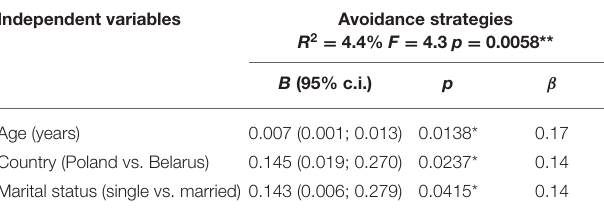
TABLE 12 | Use of avoiding coping strategies by country, age, and marital status. Independent